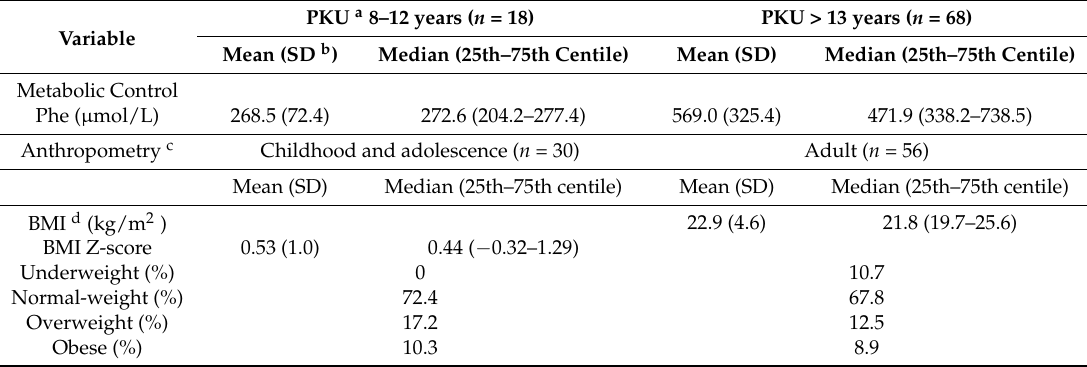
Table 1. Characteristics of